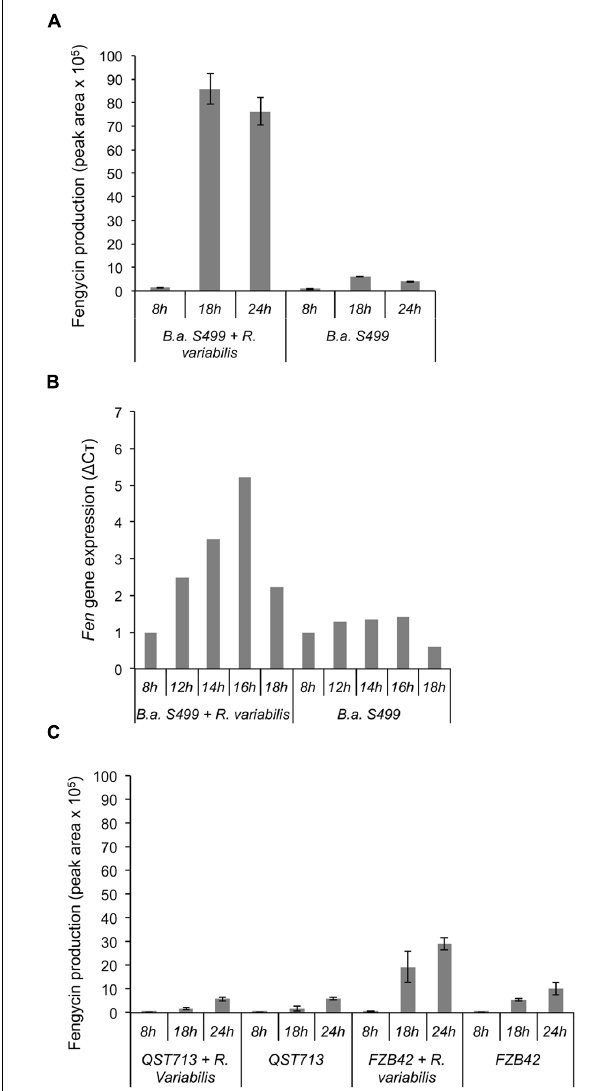
FIGURE 7 | Impact of the fungus on the production of fengycin and fenC gene expression. (A) Evaluation of fengycin production by B. amyloliquefaciens S499 ( B.a. S499 ), using UPLC–MS, in presence ( B.a. S499 + R. variabilis ) or absence ( B.a. S499 ) of R. variabilis after 8, 18, and 24 h. Positive impact of fungus is clearly visible after 18 and 24 h of co-culture. (B) Correlation between fenC gene relative expression ( (cid:49) Cò) and the lipopeptide production. A positive impact on gene expression is clearly visible after 12 h of growth when the fungal pathogen is present compare to culture of Bacillus alone. (C) Fengycin production by B. amyloliquefaciens QST713 and FZB42 in presence ( QST713/FZB42 + R. variabilis ) or absence ( QST713/FZB42 ) of R. variabilis after 8, 18, and 24 h. For UPLC–MS analysis, data are means and SD from four samples whereas RT-qPCR experiments were performed in duplicate and values at each time-point represent means calculated from two measurements coming from two independent